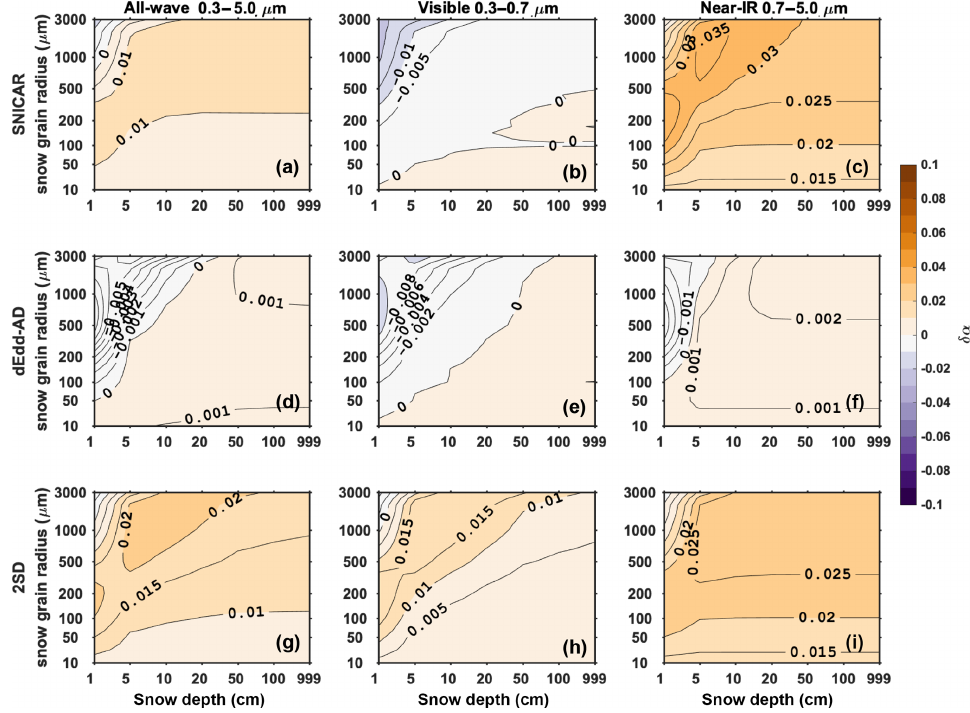
Figure 6. The difference in diffuse snow albedo ( δα = α 2 − α 16 ) computed using two-stream models ( α 2 ) and using the 16-stream DISORT